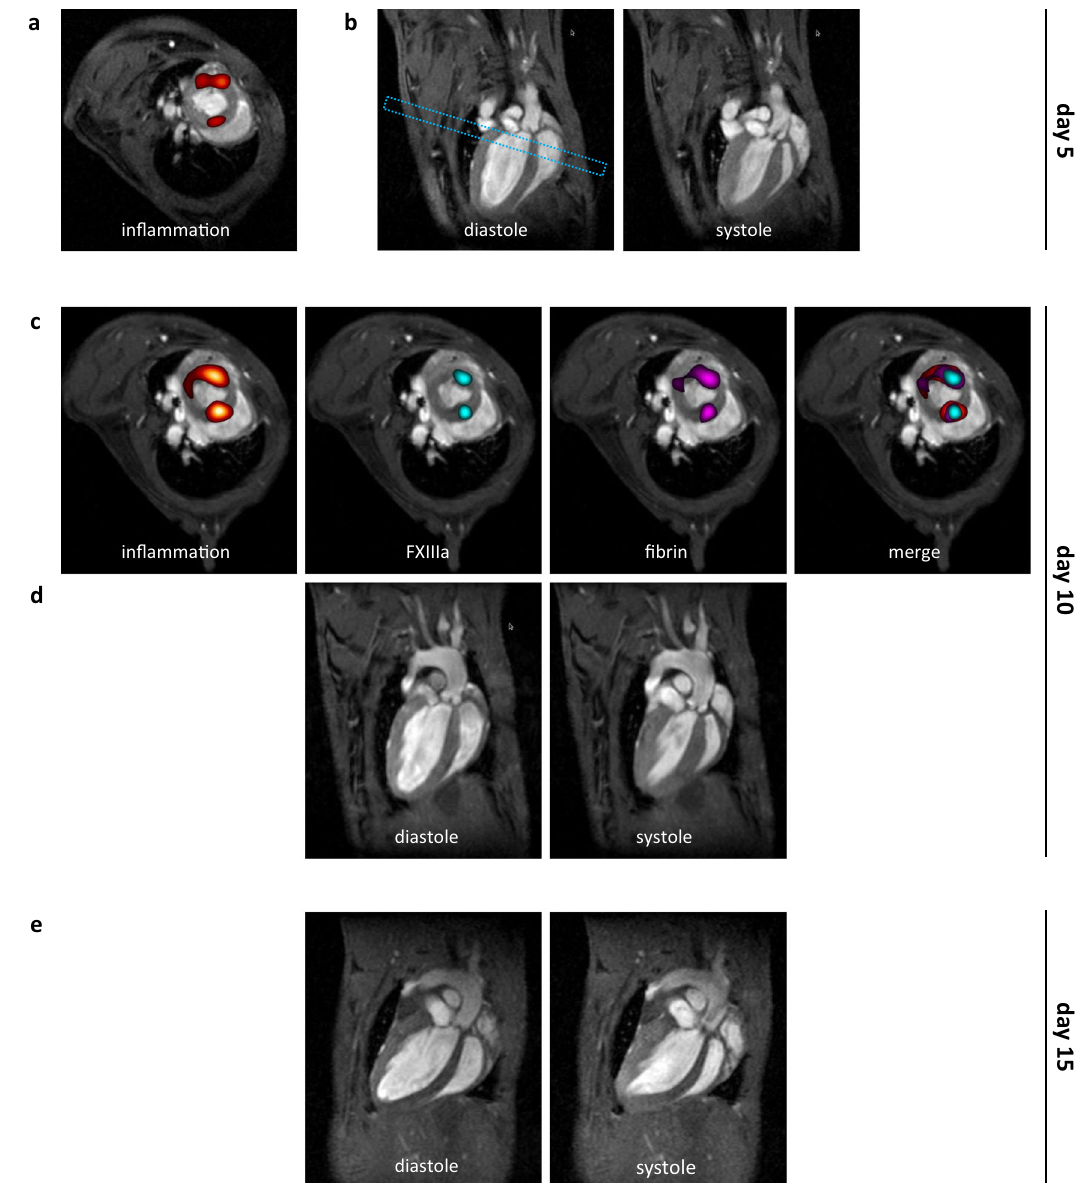
Fig. 3 Multi-targeted PFCs for thromboin fl ammatory states. Concurrent monitoring of PFCs targeting in fl ammation (red), FXIIIa (cyan) and fi brin (magenta) in the same mouse 5 days (a + b), 10 days (c + d) and 15 (e) days after onset of the diet. 19 F mCSSI data are superimposed over anatomical 1 H MRI data (greyscale). First investigation on day 5 indicated a low cardiac in fl ammation at base level and b normal function in long axis views in diastole and systole (LVEF 67.5%). The dashed rectangle indicates the perpendicular view shown in a + c. Follow-up on day 10 revealed c enhanced in fi ltration of immune cells and both freshly developed (FXIIIa + fi brin) and persisting thrombosis ( fi brin only) at sites of preceding in fl ammation (cf. a). d Despite incipient thrombosis in the left ventricle cardiac function still is preserved at this time (LVEF 66.4%). e Further check-up on day 15 depicts diastolic dilation and massively impaired systolic function (LVEF